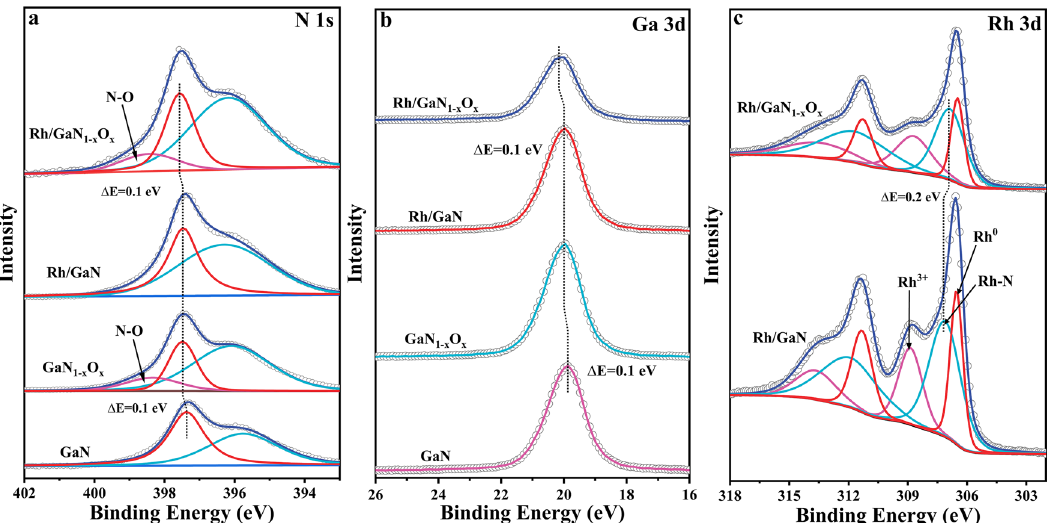
Fig. 2 X-ray photoelectron spectroscopy analysis of as-prepared samples. High-resolution XPS spectra of N 1s ( a ), Ga 3d ( b ) and Rh 3d ( c ) for GaN, GaN 1 – x O x , Rh/GaN, and Rh/GaN 1 – x O x